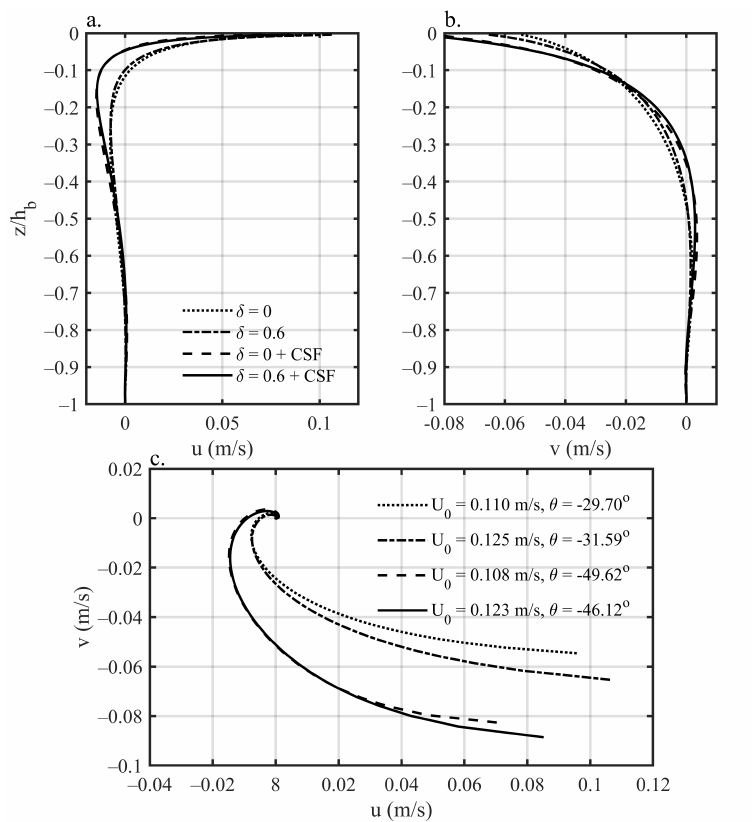
Figure 4. Time-averaged current profile in ( a ) diurnal period for zonal velocity, ( b ) meridional velocity, and ( c ) the Ekman-like spiral, under steady wind stress and at the latitude of 45° N. The dotted and dotted-dashed black lines stand for cases without considering CSF, while the dashed and solid black lines stand for cases including CSF, in which δ = 0 and δ = 0.6 stand for non-periodic and periodic cycles of mixing cases, respectively. U 0 shown in c is the magnitude of the surface current, and θ is the angle between the wind and surface current, while the negative sign in θ means clockwise rotation.